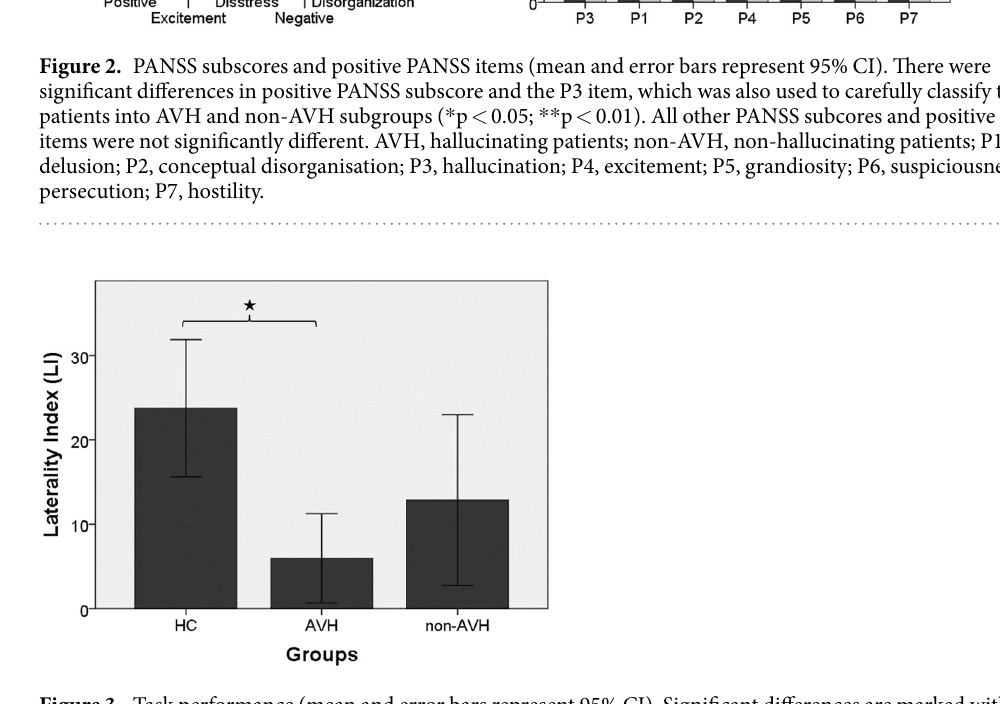
Figure 3. Task performance (mean and error bars represent 95% CI). Significant differences are marked with an asterisk ( * p < 0.05). HC, healthy controls; AVH, hallucinating patients; non-AVH, non-hallucinating